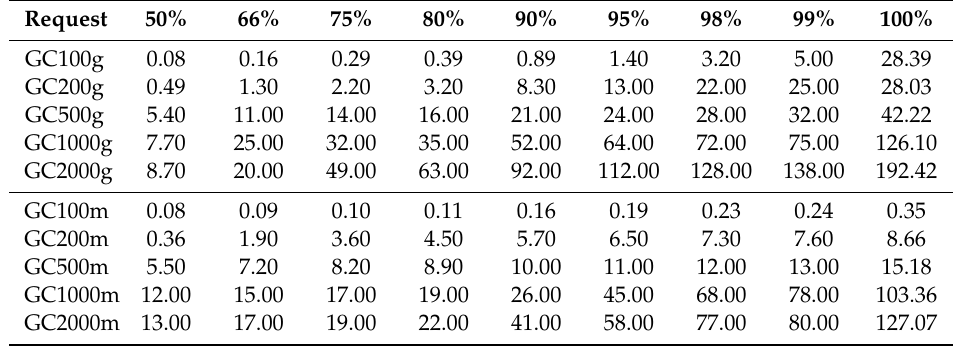
Table 13. Percentage of getCapabilities requests completed within given times (in seconds) for the di ff erent configuration of concurrent users and WSGI server (case B).